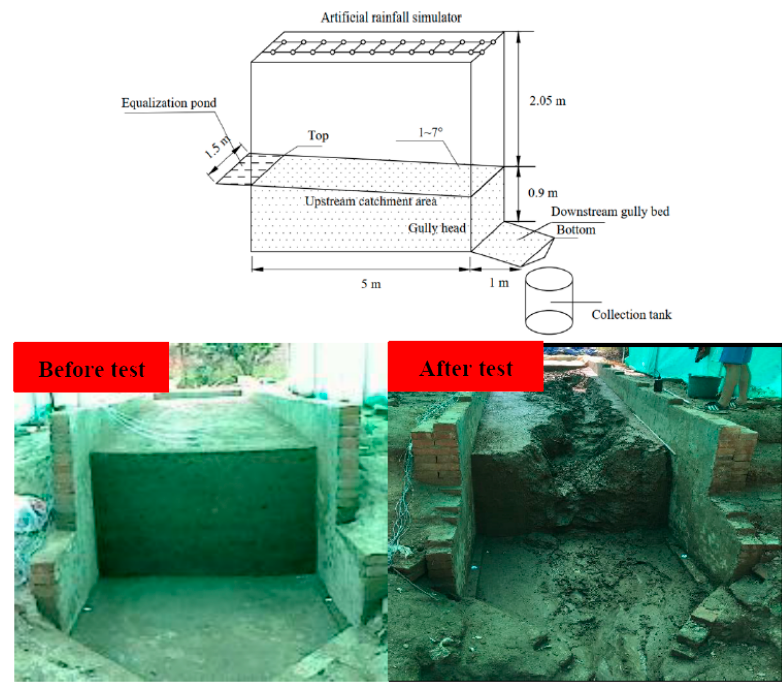
Figure 3. Schematic diagram and experimental processes of the simulated experimental plot.